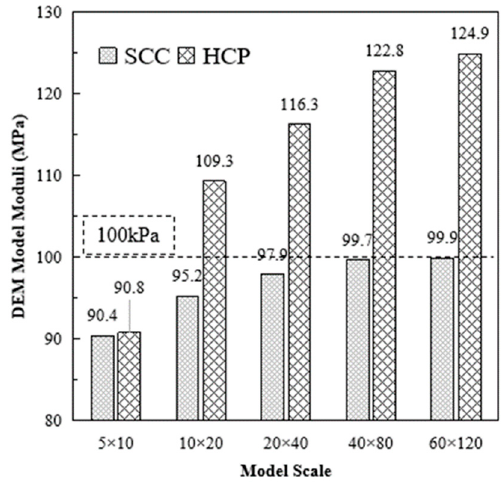
Figure 6. DEM Model Moduli of SCC and HCP Stiffness Validation Models without Boding.